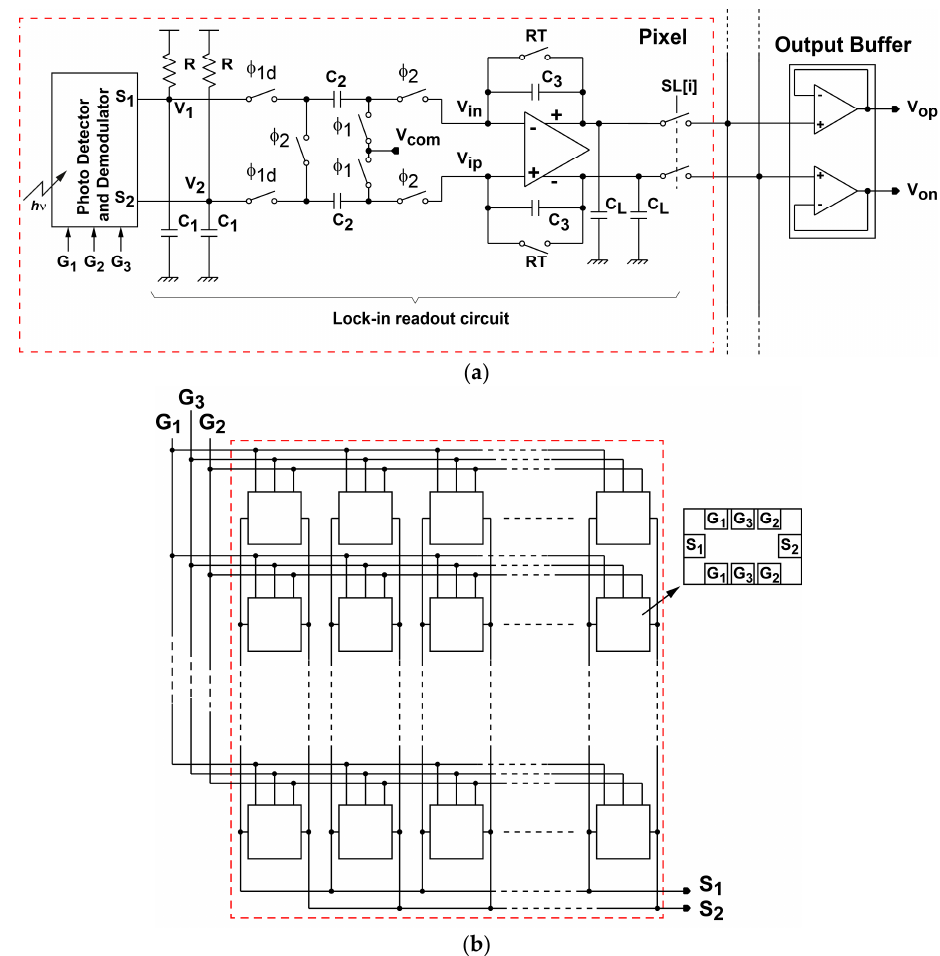
Figure 7. Lock-in pixel readout circuit: ( a ) lock-in readout circuit ( b ) photo detector and demodulator.